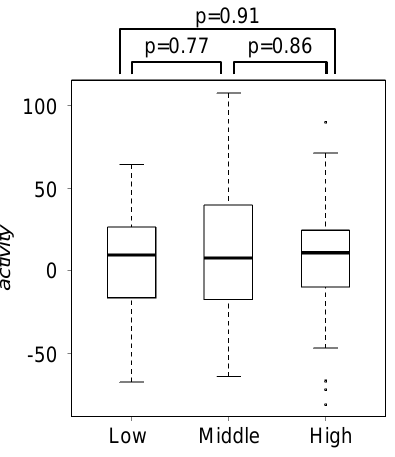
Fig. 10. Brain activity of each question in Arithmetic